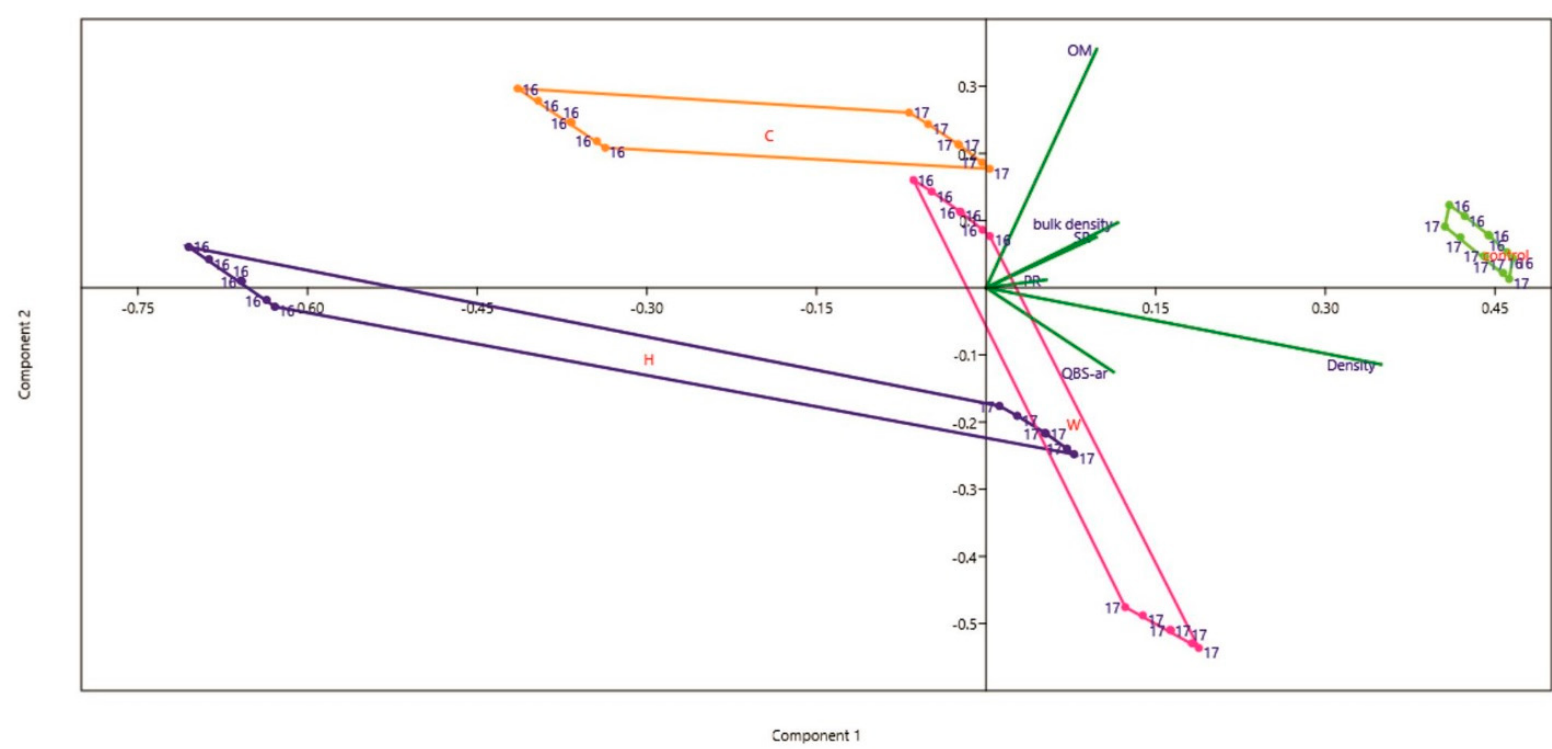
Figure 8. Score plot of the components PC1 and PC2 of the principal component analysis referred to soil characteristics. C (orange): strips harvested by cable yarder; W (pink): strips harvested by winch; H (violet): strips harvested by horse; Control (green): stand not harvested. The numbers 16 and 17 represent the years 2016 and 2017, respectively.